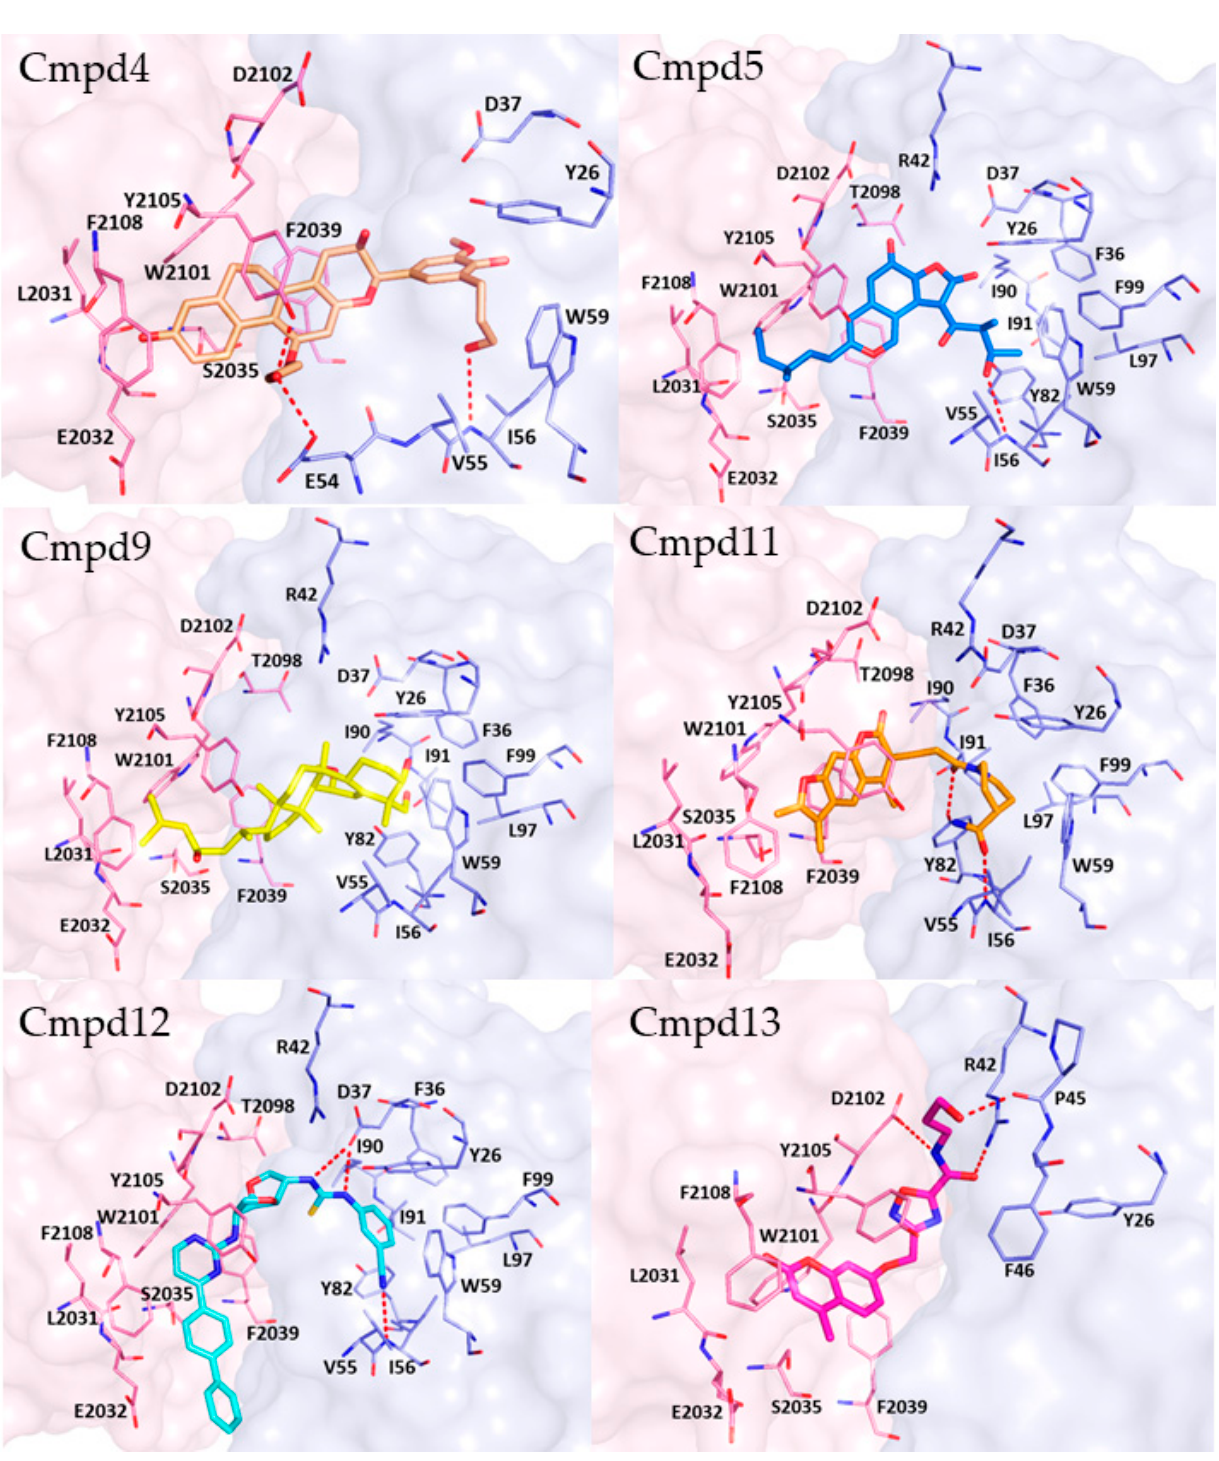
Figure 7. Plausible binding mode for each selected compound ( 4 , 5 , 9 , 11 , 12 , or 13 ). The residues of FRB domain and FKBP12 are highlighted respectively as pink and light blue sticks. Each compound is represented in sticks. H-bonds are represented by red dashed lines. The image was created by using PyMOL 2.4.0 19/05/2020 software (https://pymol.org/).